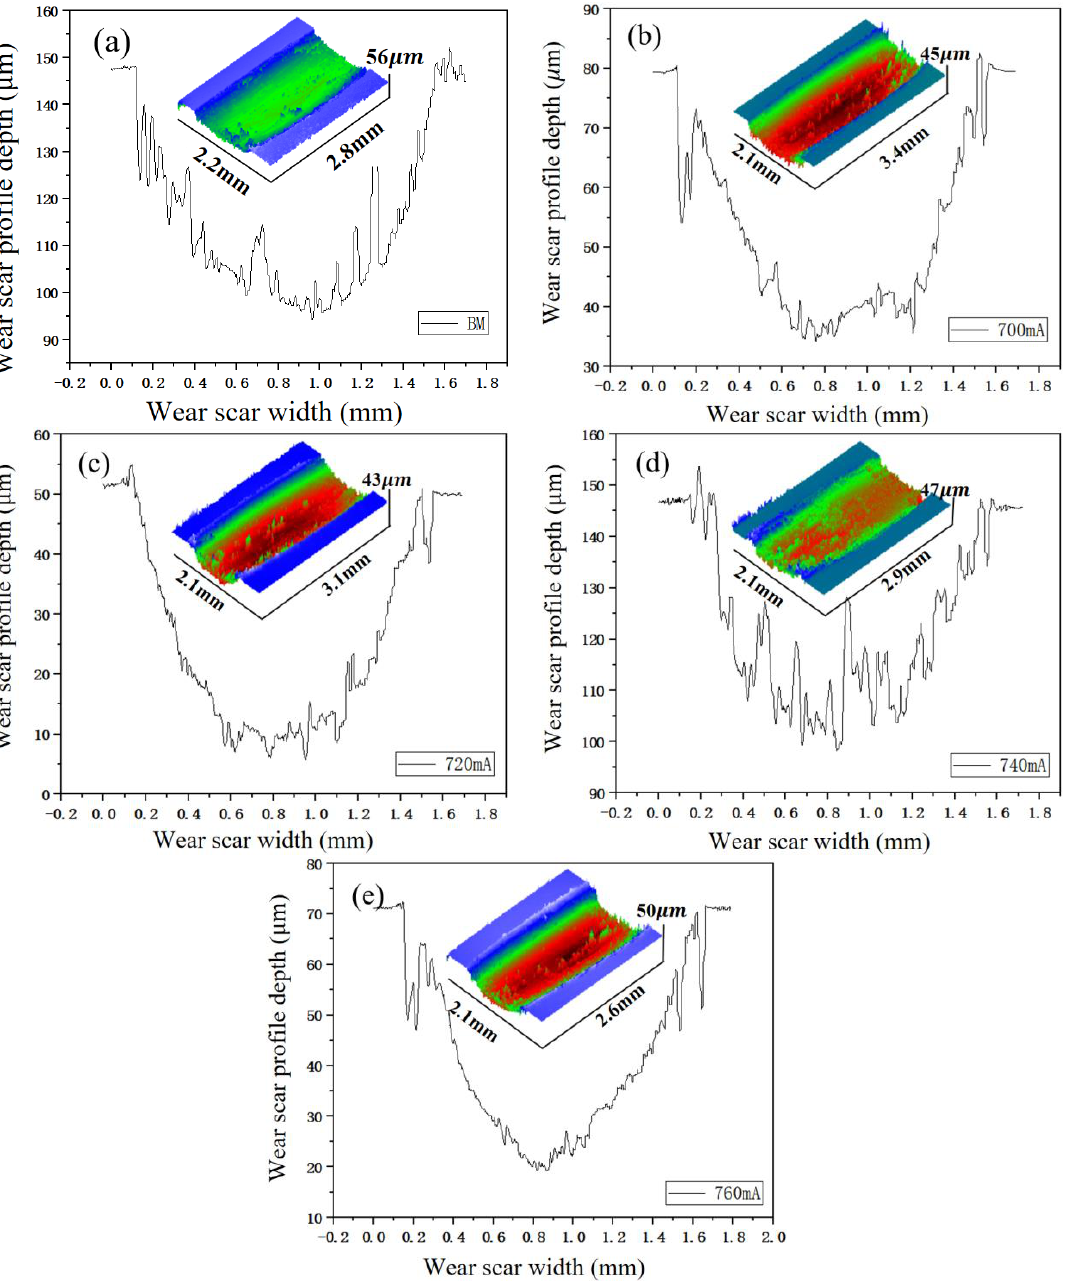
Figure 7. Three-dimensional morphology and cross-section curve of the wear surface under different conditions: ( a ) Base metal, ( b ) 700 mA, ( c ) 720 mA, ( d ) 740 mA, and ( e ) 760 mA.